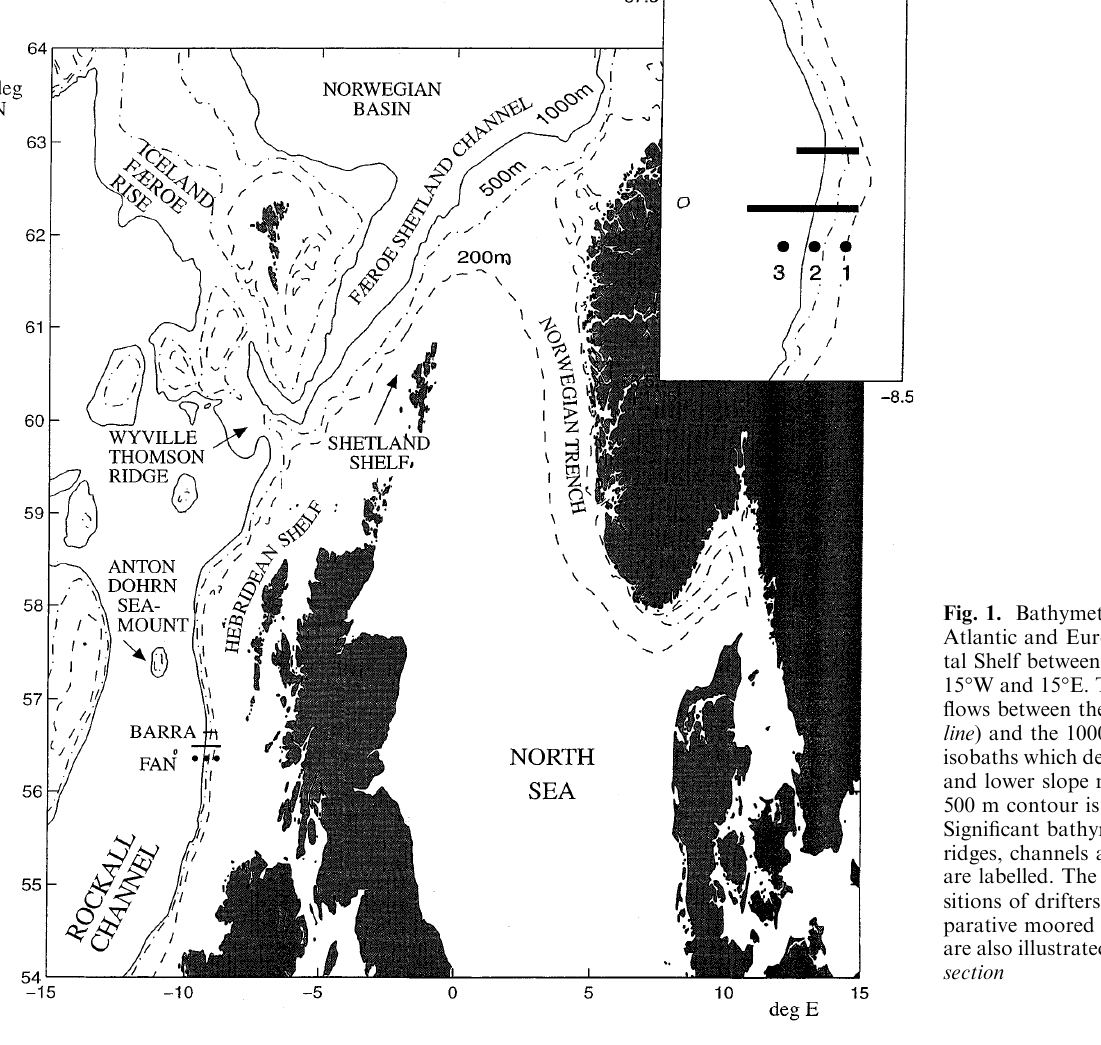
Fig. 1. Bathymetry of the North Atlantic and European Continen- tal Shelf between 54 (cid:176) N, 64 (cid:176) N, 15 (cid:176) W and 15 (cid:176) E. The slope current flows between the 200 m ( dashed line ) and the 1000 m ( solid line ) isobaths which delineate the upper and lower slope margins. The 500 m contour is also shown. Significant bathymetric features; ridges, channels and seamounts, are labelled. The deployment po- sitions of drifters ( d ) and com- parative moored instruments (–) are also illustrated in the expanded